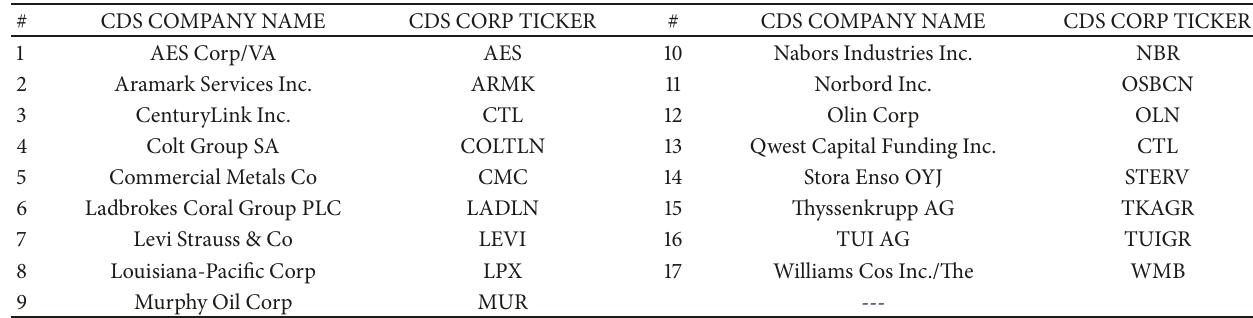
Table 9: Companies used for the HY BB sample.